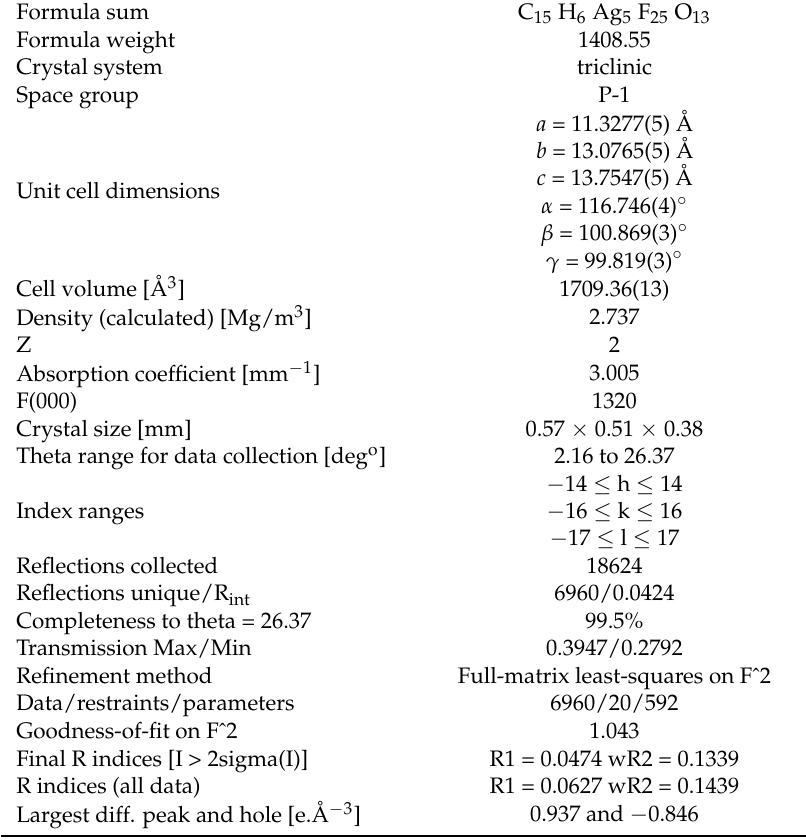
Table 7. Crystal data and structure refinement for [Ag 5 (O 2 CC 2 F 5 ) 5 (H 2 O) 3